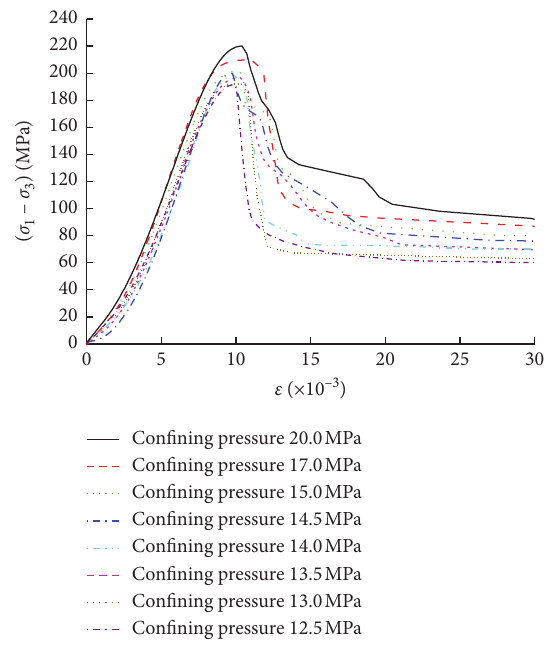
Figure 5: Stress-strain curves of the conventional triaxial com- pression